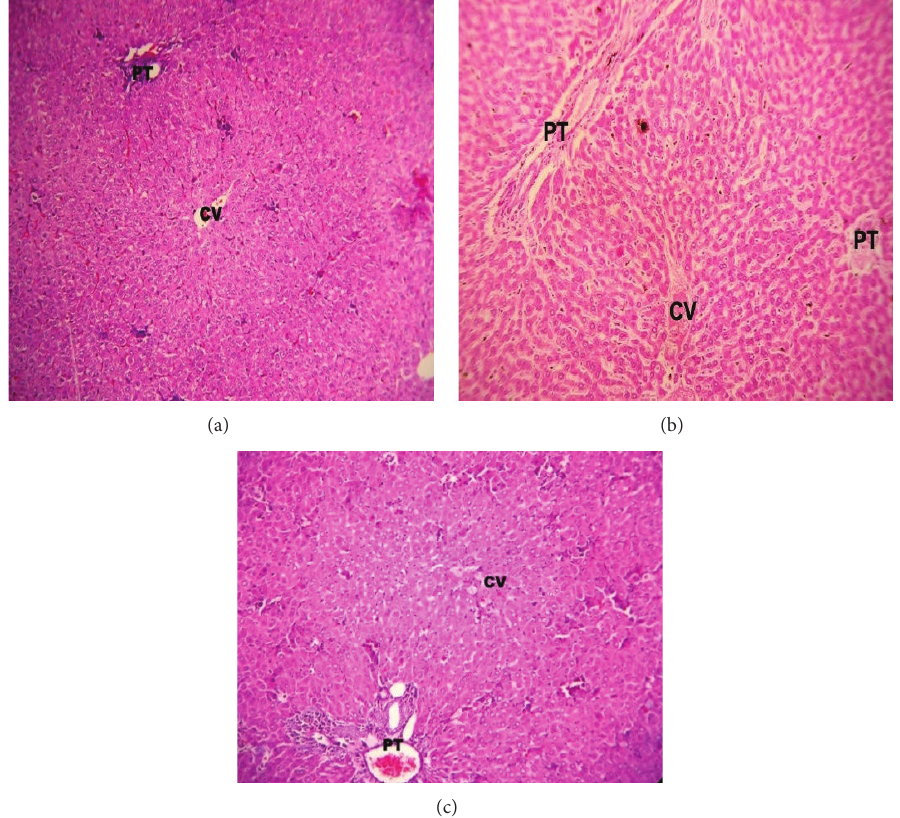
Figure 2: High power photomicrograph of portal triad area of liver tissue from animals treated with (a) control, (b) compound ( 5h ), and (c) compound ( 5p ) showing a normal histological appearance (HE × 400). PT, portal triad; CV, central